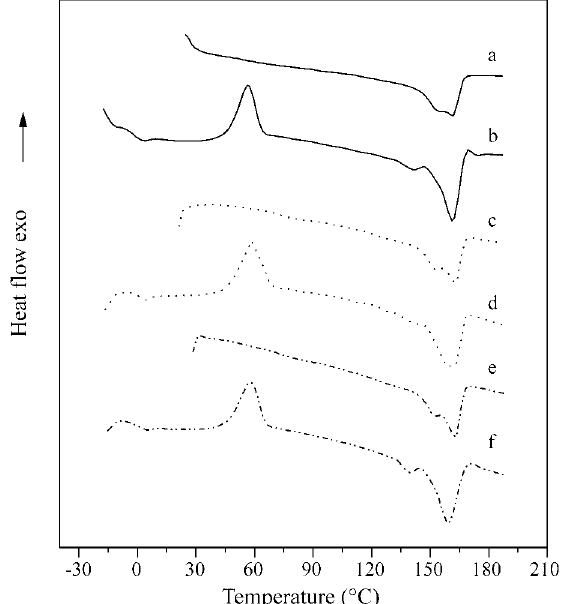
Figure 3. DSC curves for PLLA/PHBV 40/60 blends submitted to different hydrolytic degradation periods, firstheating (a,c, e) for0,36 and 53 weeks,respectively and second heating (b, d, f) for 0, 36 and 53 weeks,